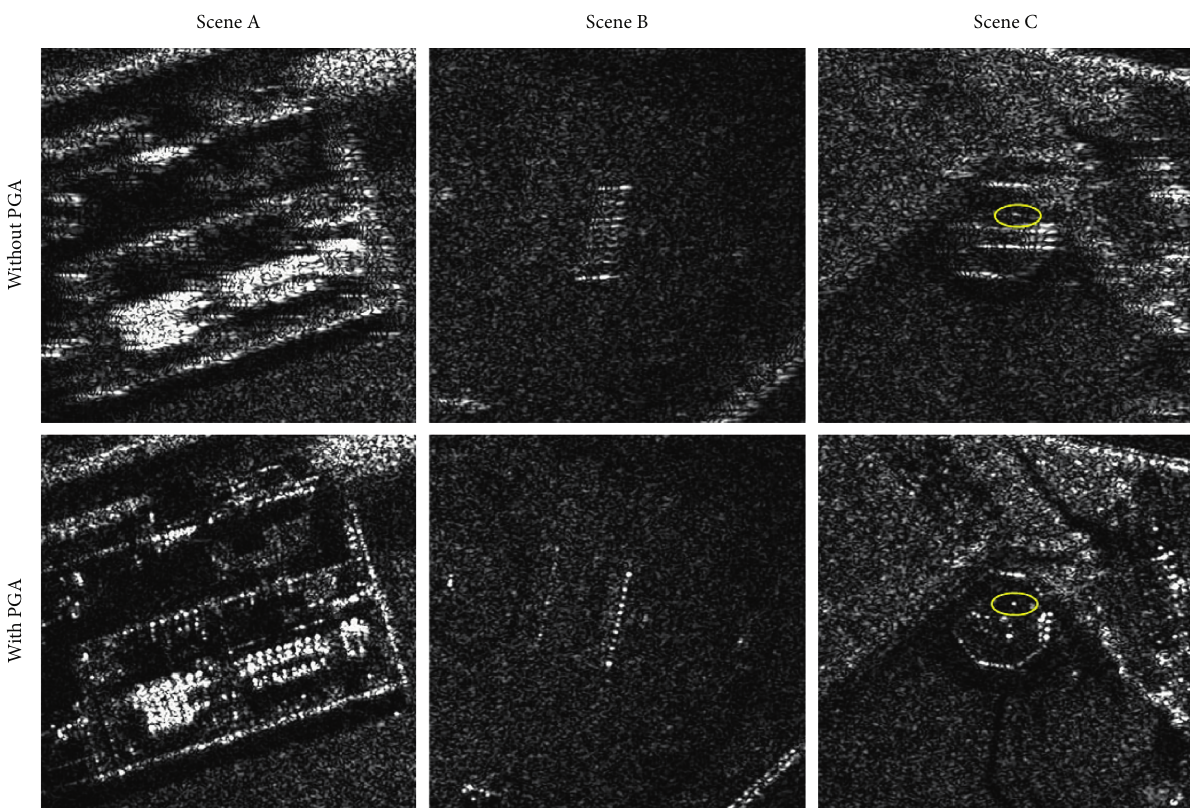
Figure 11: Magnified images of subscenes A–C in Figure